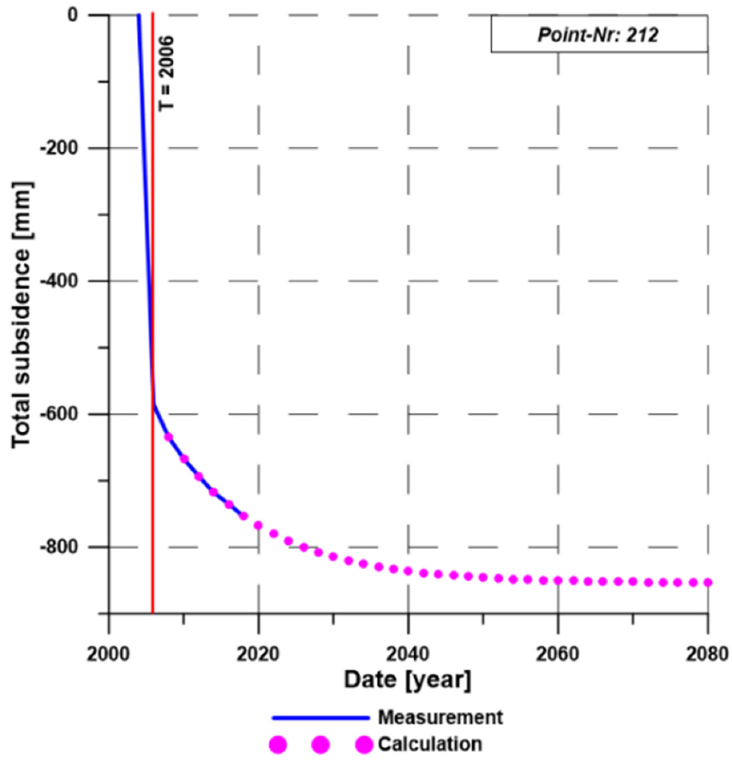
Figure 10. The course of subsidence until 2018 and the prediction of residual subsidence for the point no.